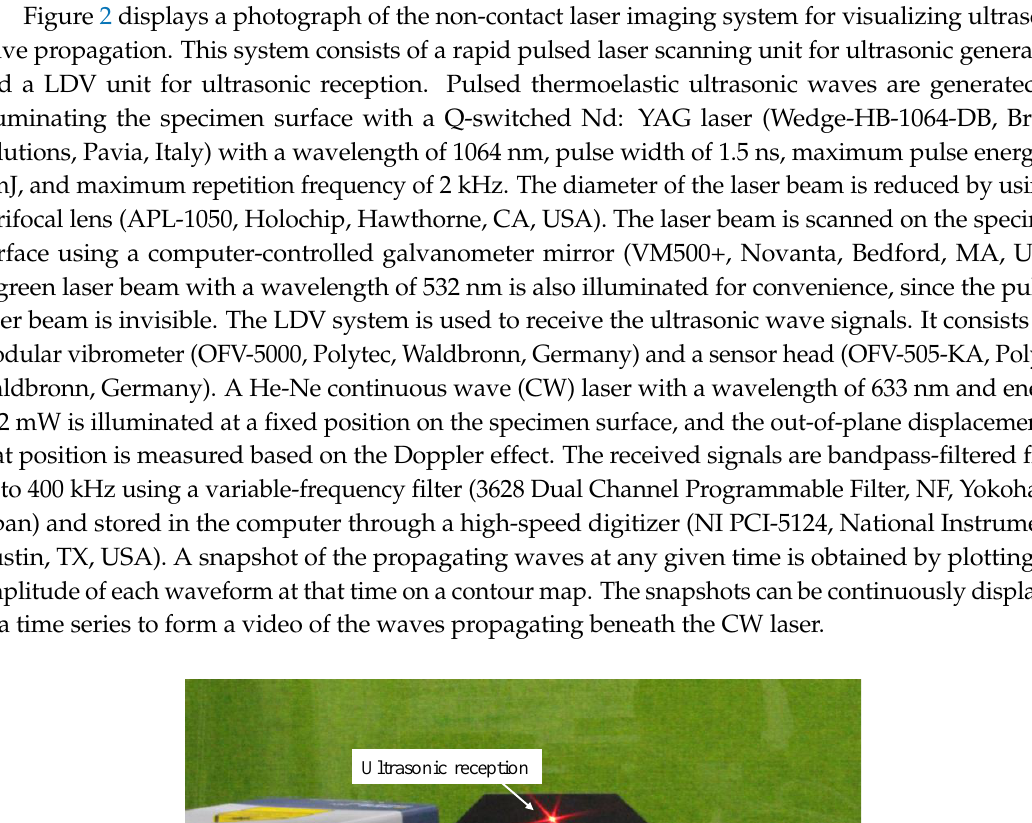
Figure 2. Photograph of the non-contact laser imaging system for visualizing ultrasonic wave propagation. Figure 1. C-scan images depicting impact-induced delamination for carbon fiber reinforced polymer (CFRP) laminates subjected to impact loading with an energy of 6 J. ( a ) [0/90] 2S , ( b ) [0/45/90/−45] S .